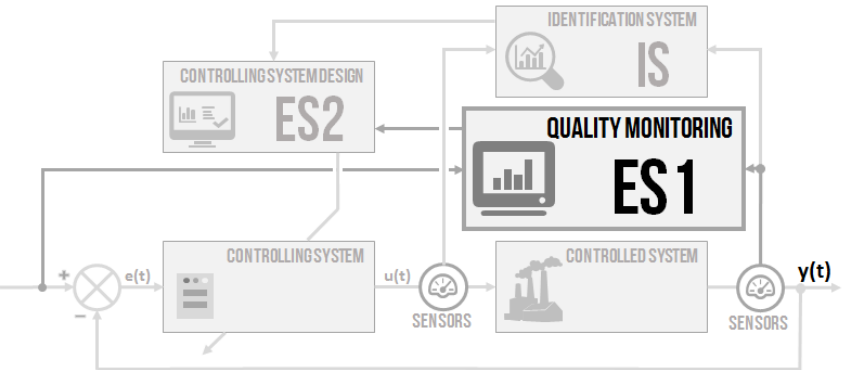
Figure 2. The schema of the concept of intelligent controlling system with outlined block of monitoring